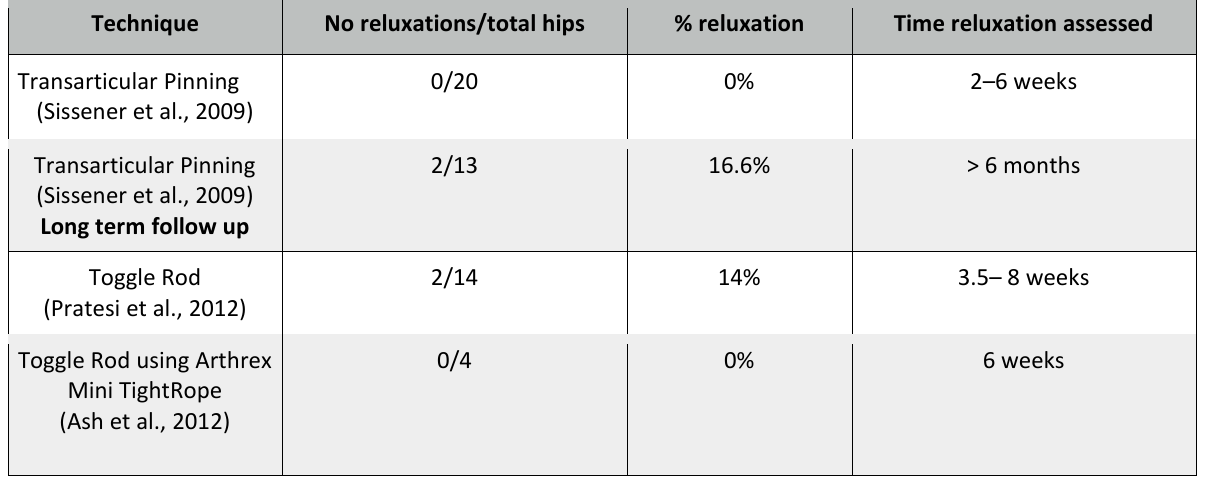
Table 1 : Reluxation rates and assessment times for the 3 studies All three studies also presented other, subjective, outcome measures that were not directly applicable to the PICO question. These included lameness assessments performed by a veterinarian and owner outcome questionnaires conducted by telephone. Along with the subjective nature of these assessments, all studies failed to describe observer standardisation, introducing observer bias, and time to follow up with owners varied widely introducing recall